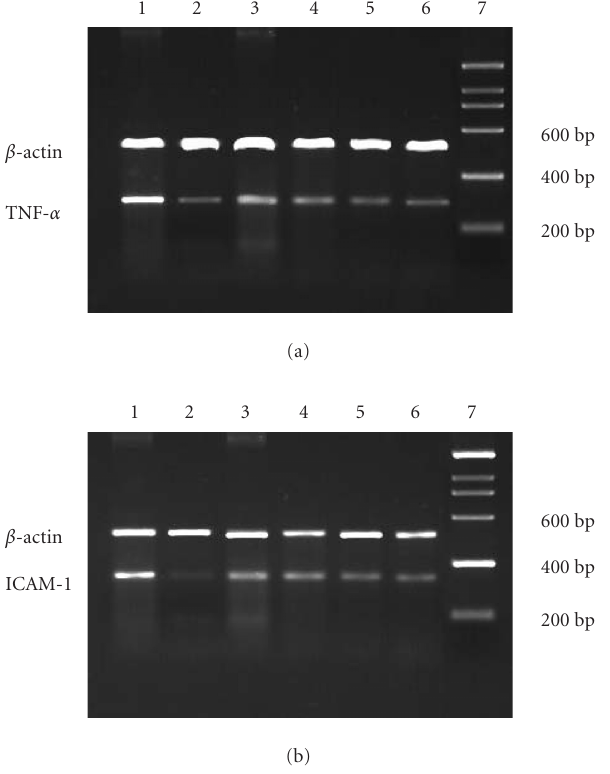
Figure 4. The mRNA expressions of (a) TNF- α and (b) ICAM-1 were assessed using RT-PCR standardized by coamplifying the housekeeping gene β -actin. Lanes 1–7: model, normal, melatonin (2.5, 5.0, 10.0 mg.kg − 1 ), 5-ASA,